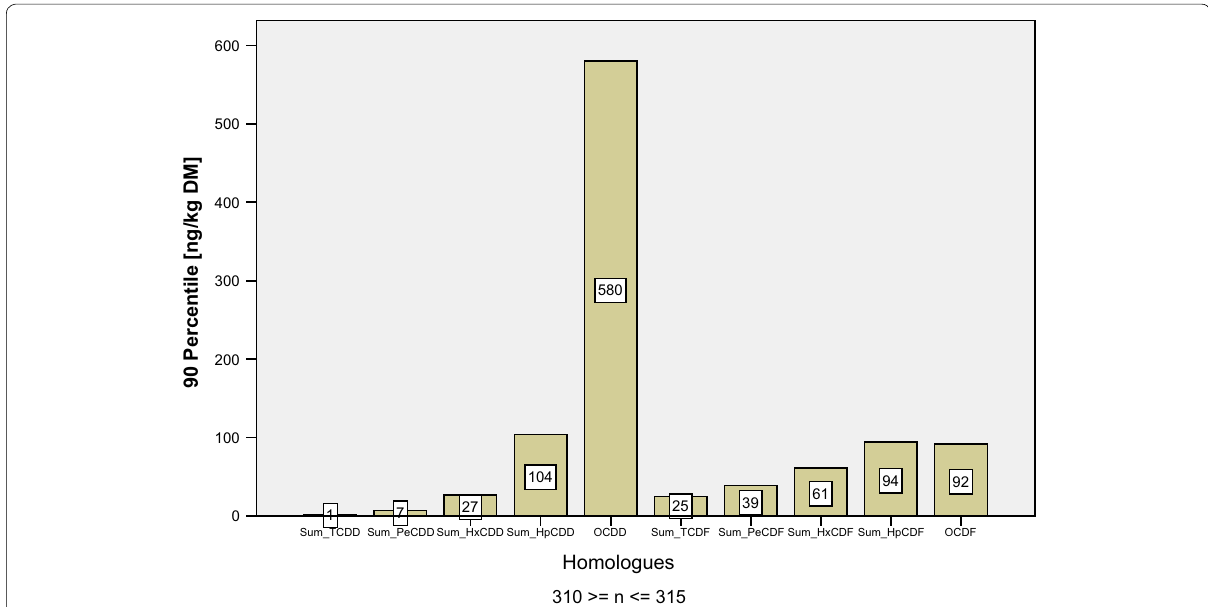
Fig. 3 Homologue pattern of 2,3,7,8-chloro subsidized PCDD/F in organic layers of Bavarian forest soils (outlier eliminated)